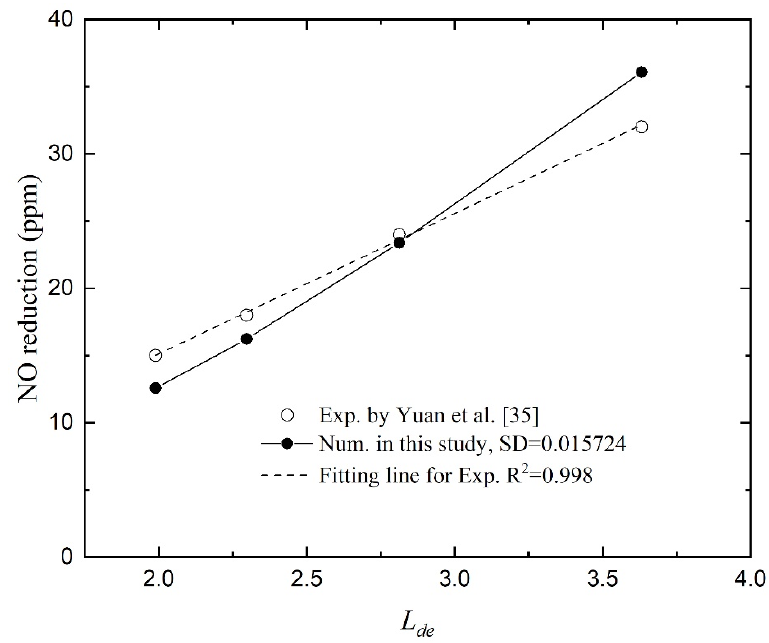
Figure 5. NO reduction as a function of equivalent diffusion